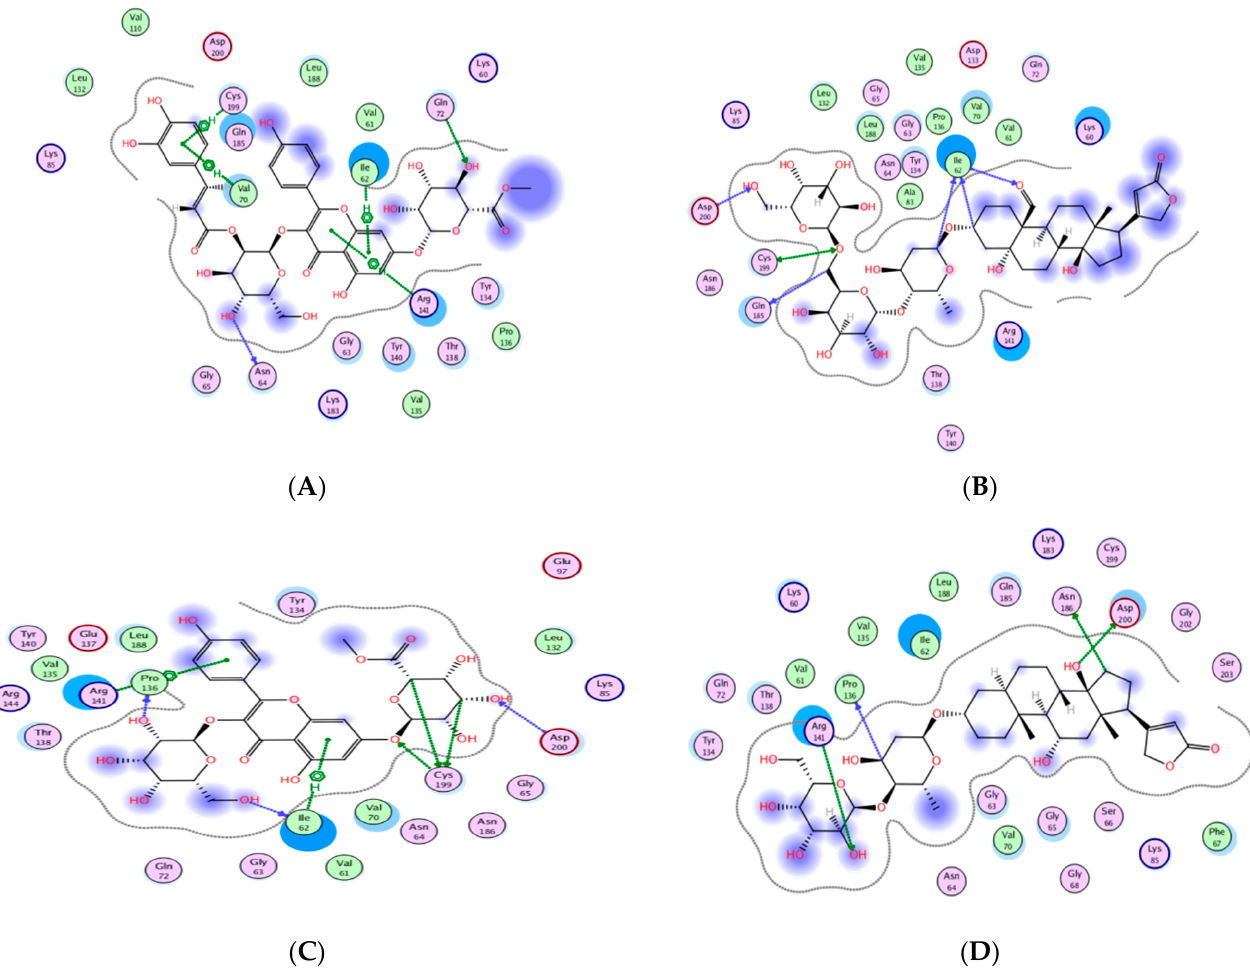
Figure 14. The 2D presentations of the molecular interaction of 14 ( A ), 16 ( B ), 19 ( C ), and 20 ( D ) with GSK3 using PDB 1Q5K.